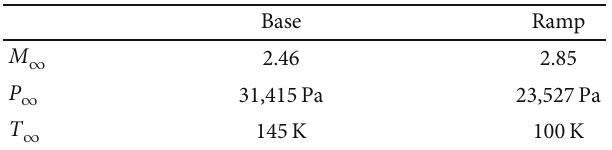
Figure 2: 24-deg compression ramp computational grid (a). Closeup view Table 3: Test conditions for the axisymmetric base (Herrin and Dutton).